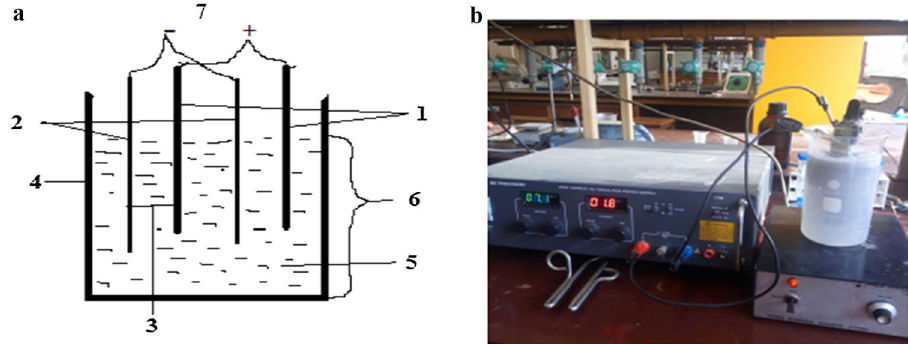
Fig. 1 Experimental setup for electrocoagulation reactions: a Schematic diagram: 1 Anode Fe or Al 2 Cathode, 3 Interelec- trode distance 1.5 cm, 4 Reactor (800 cm 3 ), 5 Water sample